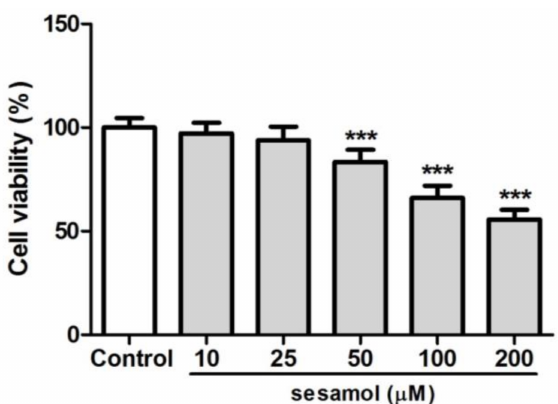
Figure 1. Cell viability (%) of B16F10 cells after 48 h of treatment with sesamol. The cell viability was below 80% at sesamol doses over 100 µ M. Each value is presented as the mean ± SD. Significant difference with control group: *** p < 0.001.